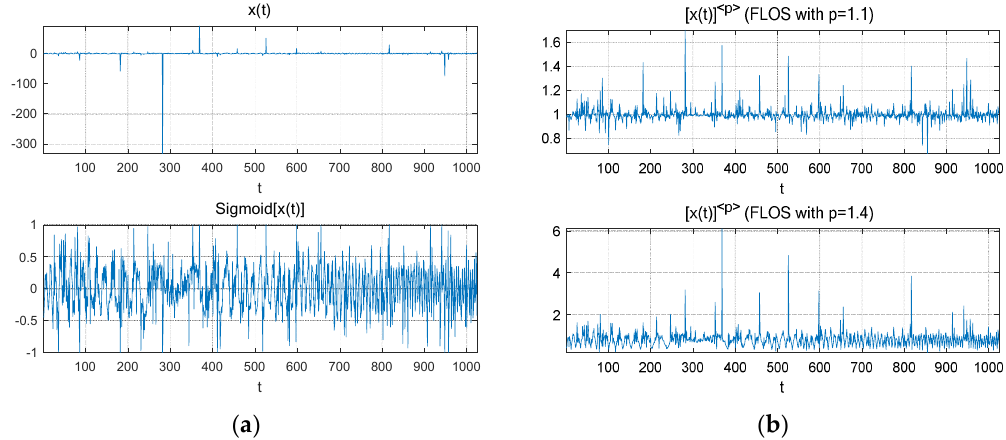
Figure 2. Comparison of the noise suppression ability for S α S with generalized signal-noise-ratio Figure 2 . Comparison of the noise suppression ability for S S  with generalized signal-noise-ratio (GSNR) = 5 dB and α = 1.2. ( a ) Sigmoid transform; ( b ) fractional lower-order statistics (FLOS) (GSNR) = 5 dB and α =1.2. ( a ) Sigmoid transform; ( b ) fractional lower-order statistics (FLOS) theory.